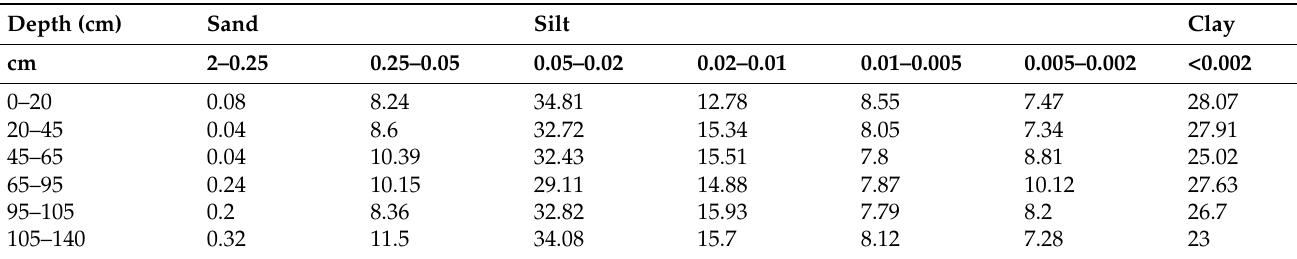
Table 2. Soil physical properties in the experimental site